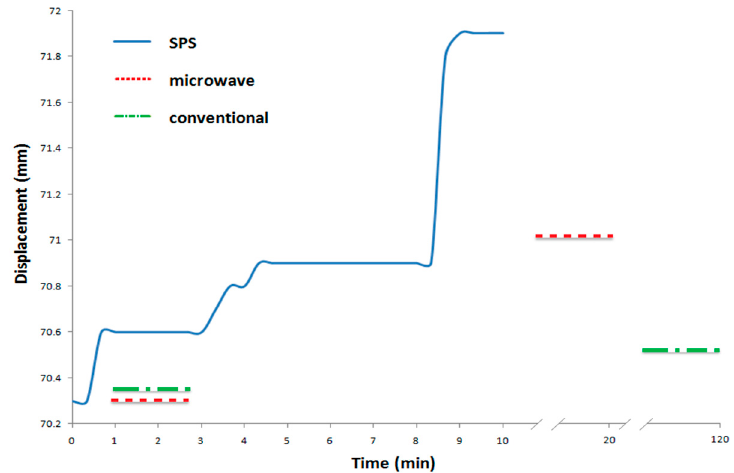
Figure 3. Displacement changes vs sintering time for SPS sintering.